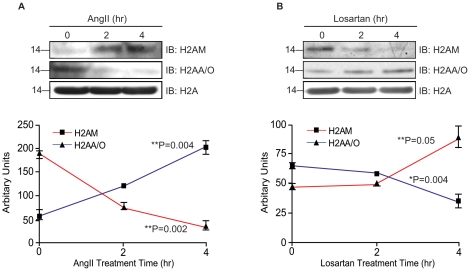
Time course analysis of ligand-dependent exchange of H2AA/O and H2AM isoforms.The H2A isoforms were immunoblotted using isoforms-specific antibodies, H2AA/O and H2AM/H2A 25P hydroxyl after treatment of HEK-AT1R with AngII (1µM) or losartan (1µM). Each data point shown represents mean ± SEM of 3–5 independent experiments. Significance values shown are for comparison between 0 and 4 hr time points, obtained by one-way ANOVA followed by unpaired Student t-test. P-values less than 0.05 are considered statistically significant.